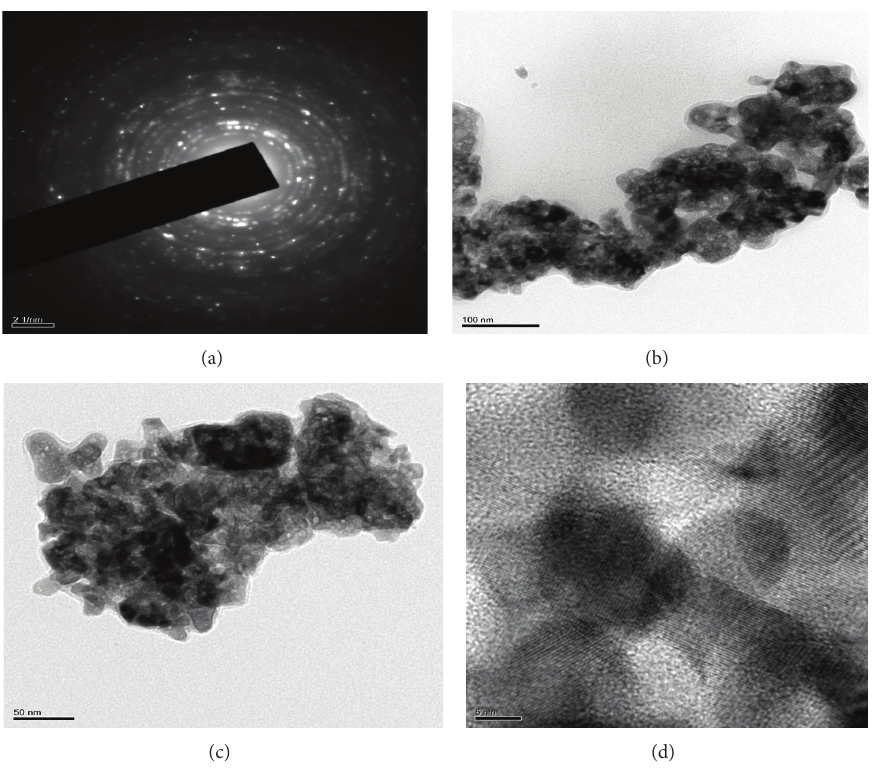
Figure 3: (a) Corresponding selected area diffraction, (b) 100 nm, (c) 50 nm, and (d) 5 nm. TEM images of sol-gel synthesized zirconium dioxide.